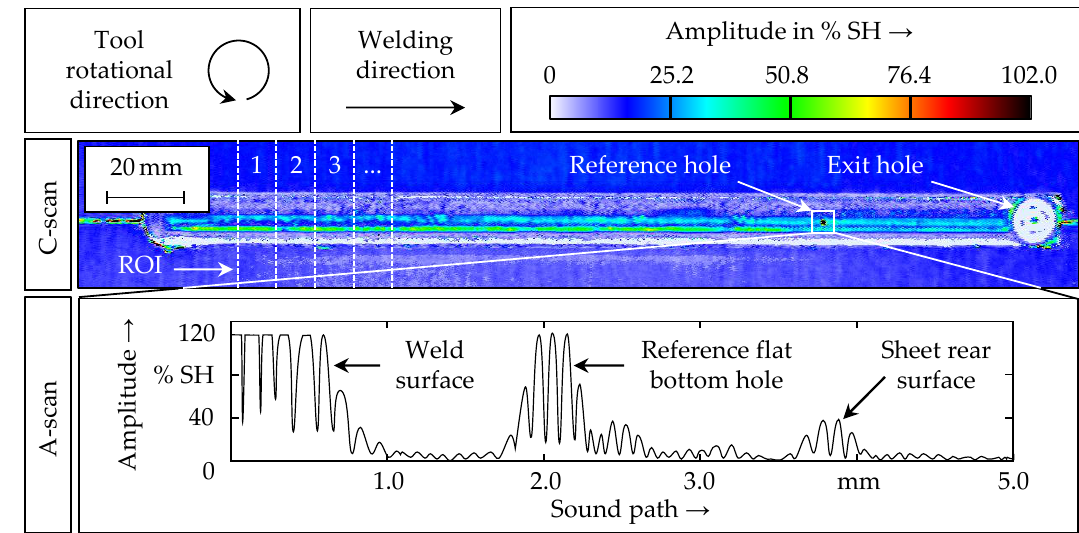
Figure 3. Examination of the welds for cavities using ultrasonic testing.